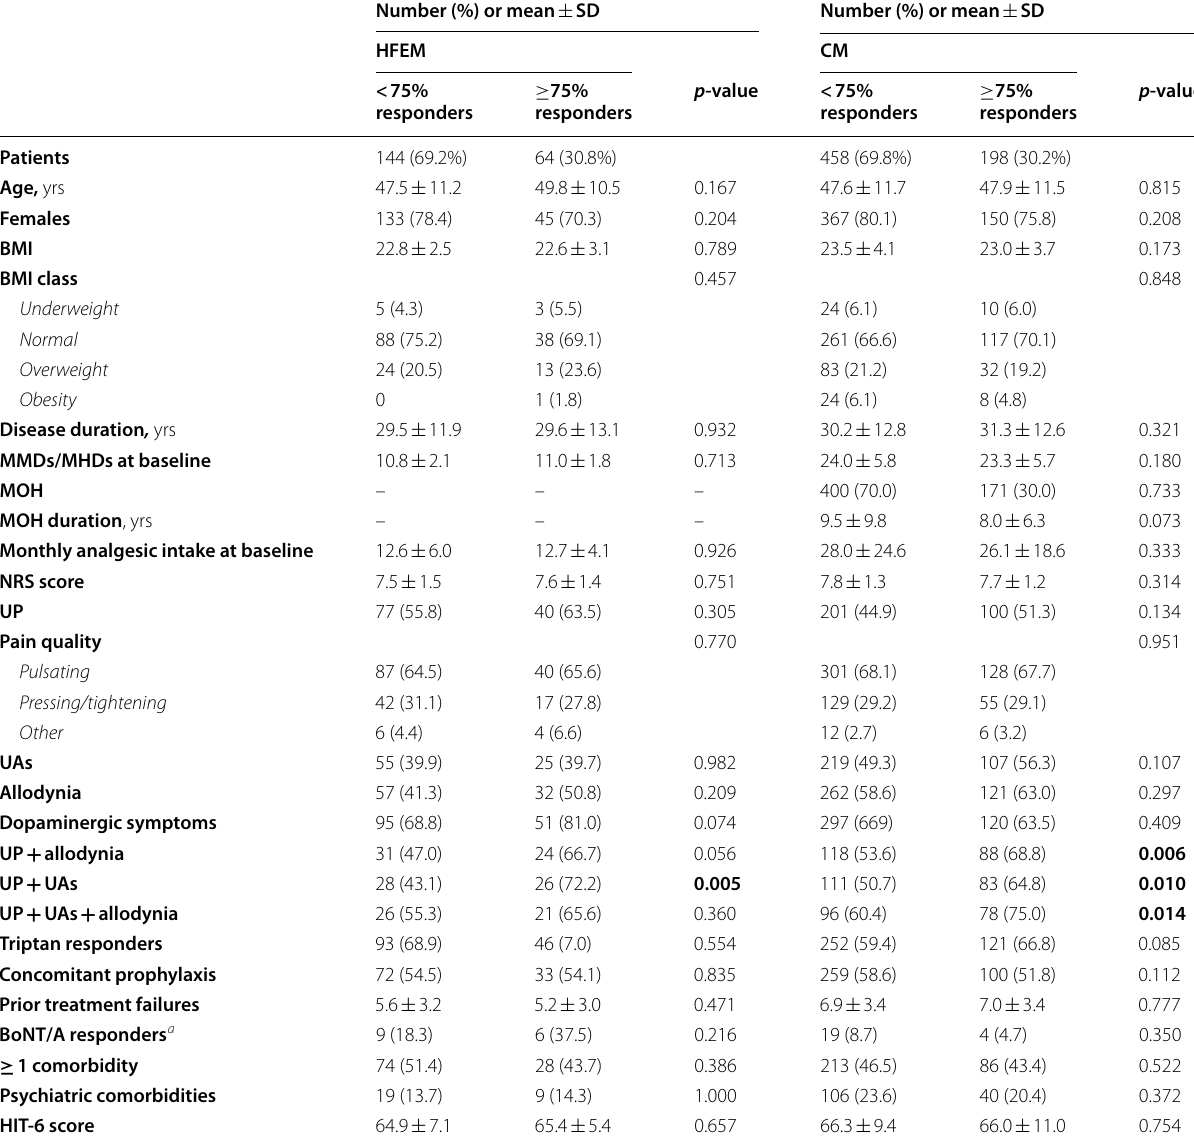
Table 3 Demographic and clinical characteristics of < 75% responders and episodic (HFEM) or chronic migraine